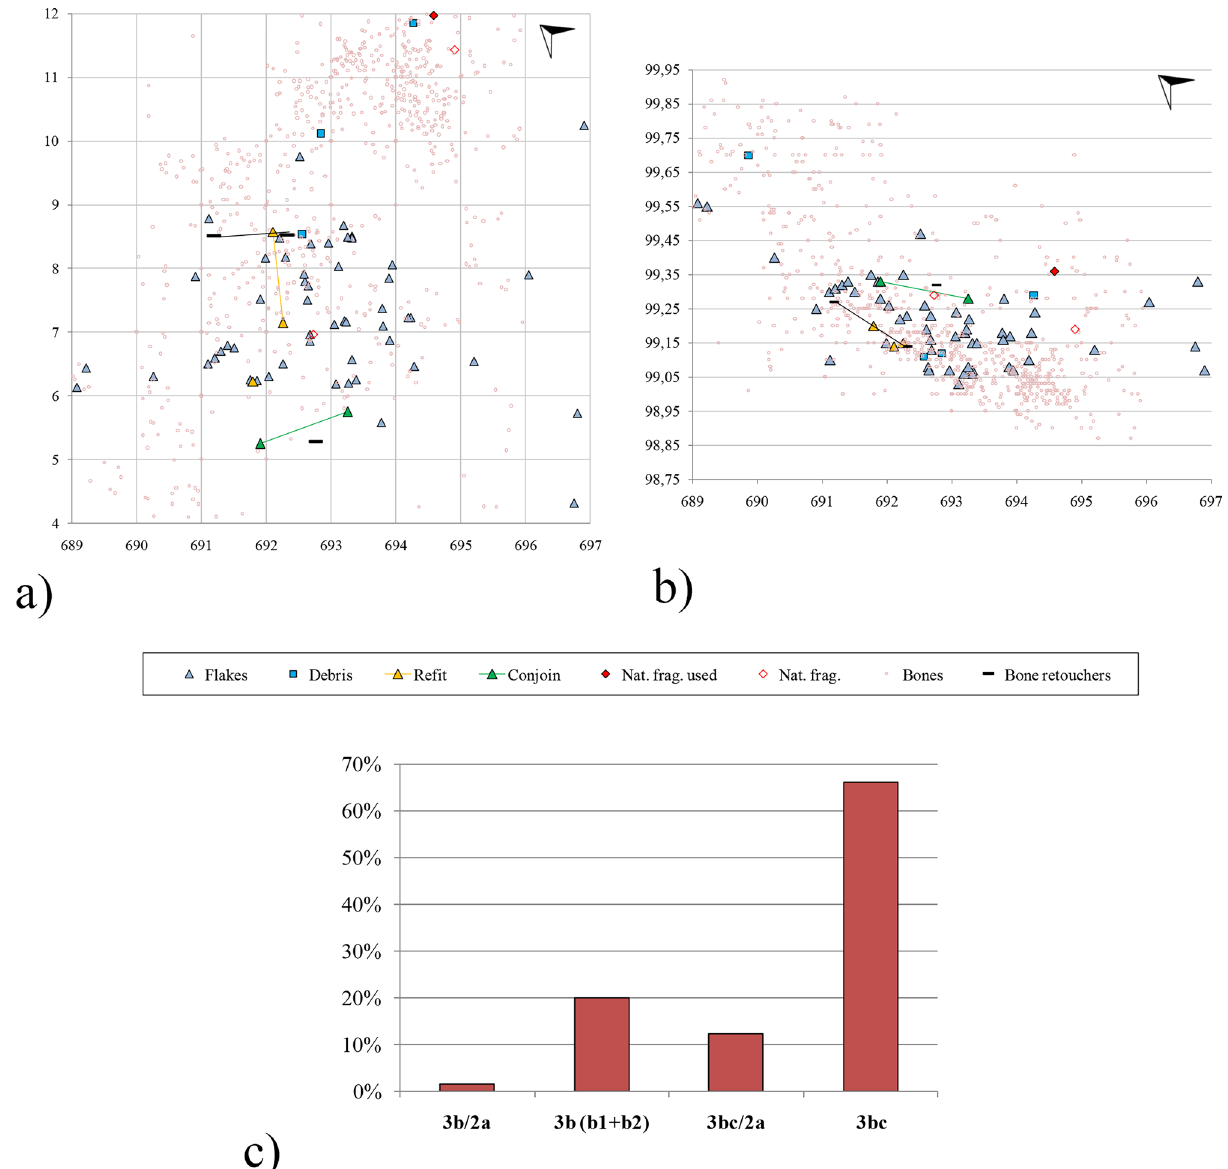
Figure 2. Spatial distribution of finds from the elephant area at Schöningen 13 II-3. State of research in August 2022. ( a,b ) horizontal (x–y axis) and vertical (x–z axis) distribution of the lithic and faunal remains; ( c ) distribution of the lithic record among the